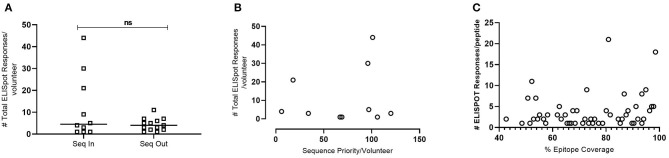
IFNγ ELISpot responses observed in HIV+ Volunteers. (A)—Number of total ELISpot responses observed in volunteers whose transmitted founder proteome sequence was included within the in-silico prediction (Seq In: N = 10) and volunteers whose transmitted founder proteome sequence was not included within the in-silico prediction (Seq Out: N = 13). Shapiro-Wilk values Seq In: W = 0.7887, p = 0.0008. Seq Out: W = 0.8976, p = 0.0315. Mann-Whitney test, p = 0.6215. (B)—Correlation of total number of ELISpot responses in volunteers whose transmitted founder proteome sequence was included within the in-silico prediction against the order of priority the sequence was predicted to occur (Spearman Correlation; r = 0.1356, p = 0.2209). (C)—Correlation of total number of ELISpot responses in volunteers whose transmitted founder proteome sequence was included within in silico prediction against the % coverage each epitope represented (Spearman Correlation; r = 0.2695, p = 0.0357).